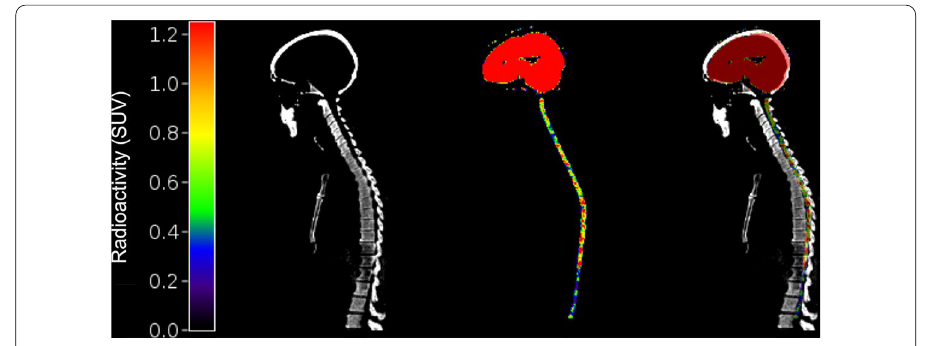
Fig. 3 Sagittal view of a CT image, a PET image (SUV, 30–60 min), and overlaid CT/PET of the Full Central Nervous System (brain SC) +